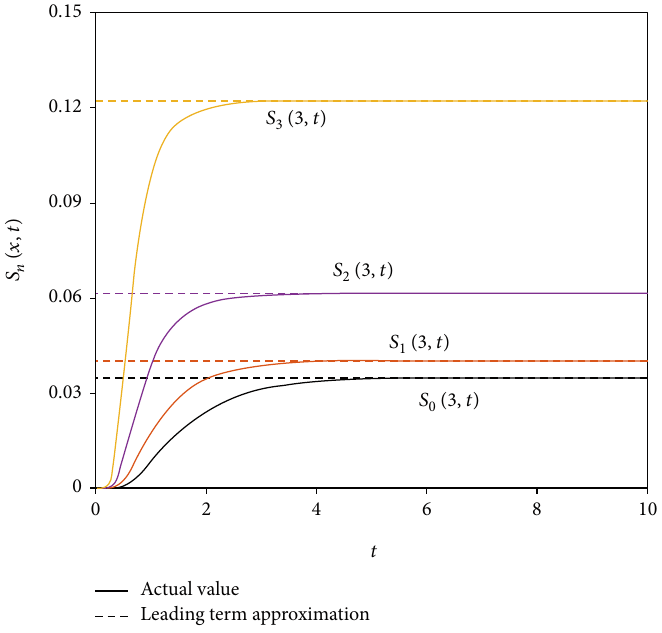
Figure 5: Leading term approximation for t ⟶ + ∞ .